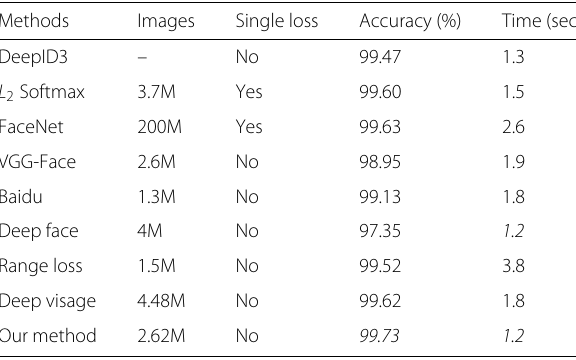
Table 4 Face verification performances on